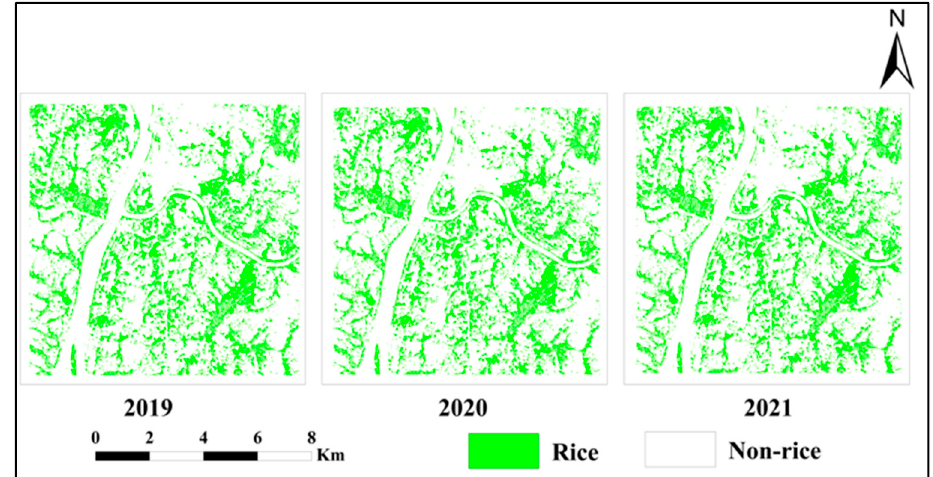
Figure 5. Spatial distribution of rice in the 2019–2021 period.